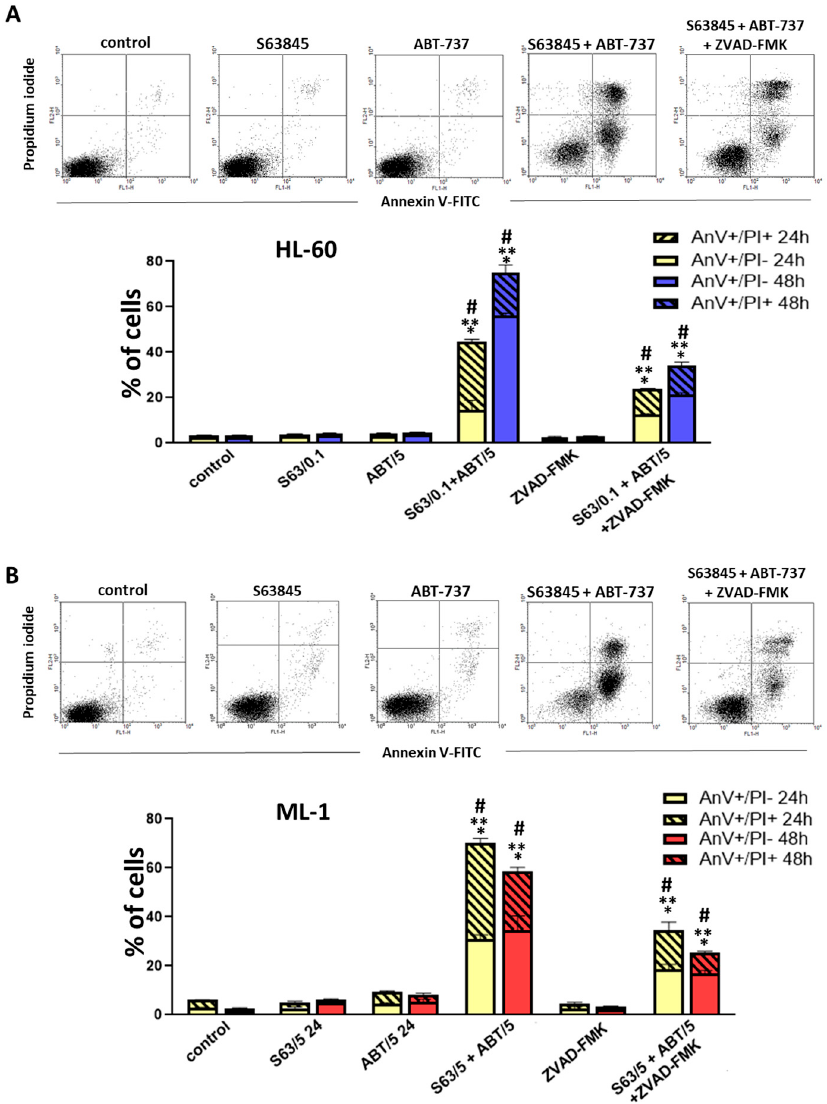
Figure 4. Effects of S63845 (S63) applied alone or in combination with ABT-737 (ABT) on apoptosis of AML cells. Apoptosis was determined in HL-60 ( A ) and ML-1 ( B ) cells by flow cytometry Annexin V-FITC/propidium iodide (PI) assay 24 h and 48 h after the agent application. ( A , B ) upper panels— the representative flow cytometry dot plots of Annexin V-FITC/PI staining obtained at the 48 h time point. Designations 0.1 and 5 indicate the agent concentrations ( µ M). Values are reported as the means ± SD of three independent experiments. Values significantly different ( p < 0.05) according to one-way ANOVA are designated by * and ** compared to, respectively, S63845 or ABT-737—single treated group; # compared to the corresponding control.